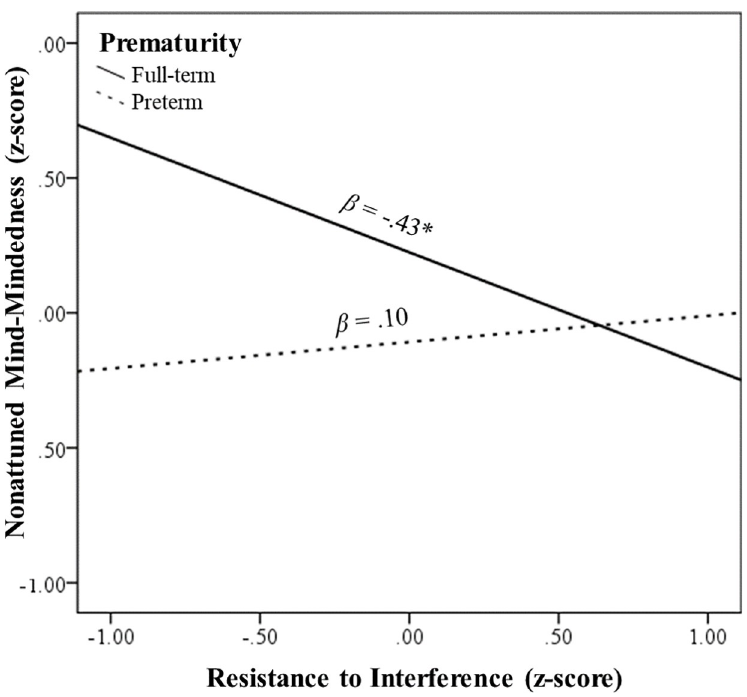
Fig 3. The links between resistance to interference (independent variable) and nonattuned mind-mindedness (dependent variable) at levels of prematurity group. Note . � p < .05.